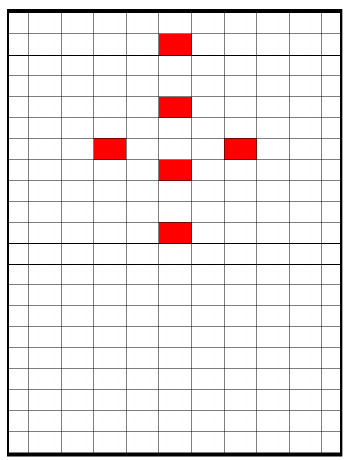
Figure 6. Poses in one-foot sole.